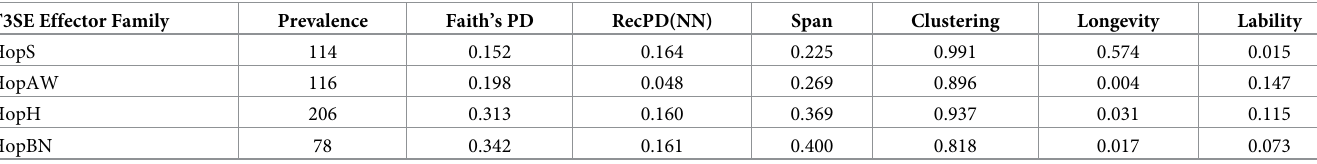
Table 3. RecPD and associated measures for selected effector families shown in Fig